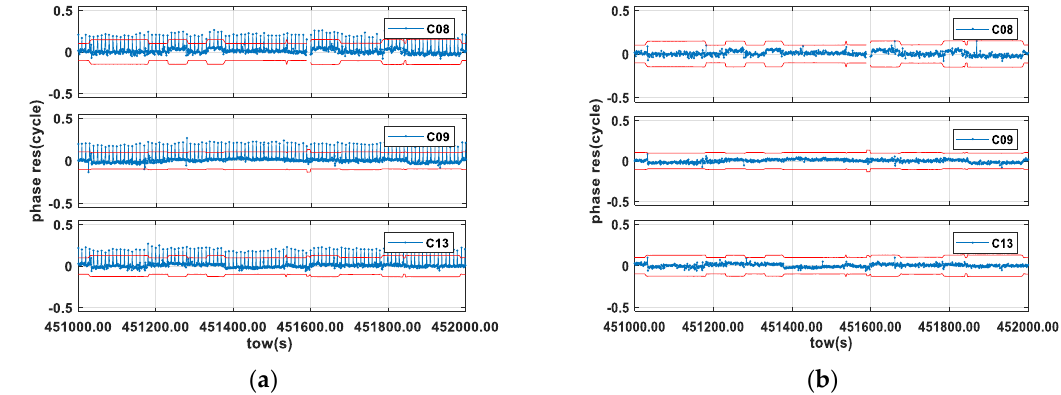
Figure 6. Residuals of carrier phase in simulated experiment: ( a ) prediction residuals of carrier phase; ( b ) residuals of the retained carrier phase measurements by MAQC method. The rea lines symbolize the threshold value. The blue lines symbolize the residuals.